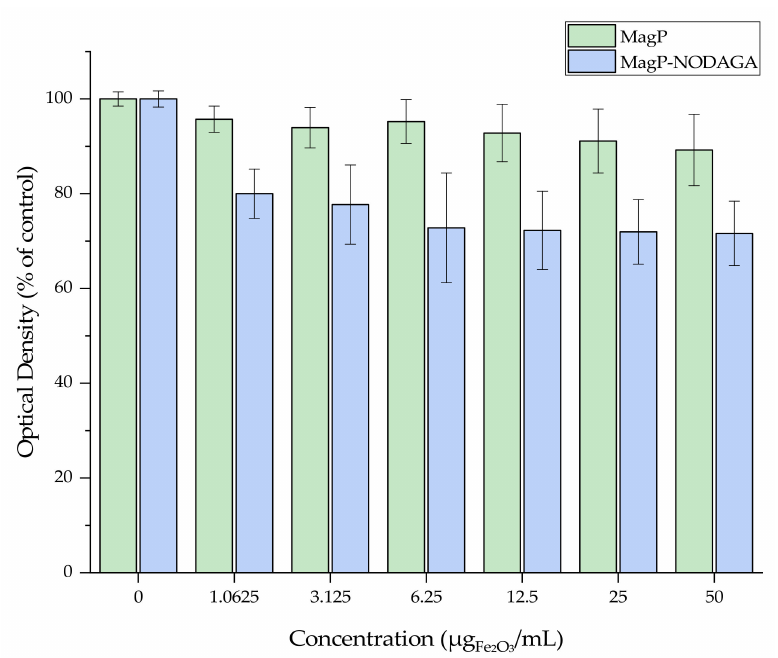
Figure 5. MTT assay of 4T1 cells treated with different concentrations of MagP and MagP-NODAGA MIONs. Zero concentration corresponds to the negative control for both NPs (no nanoparticles present in the sample). Mean values ( n = 3) and the SD (bars) are